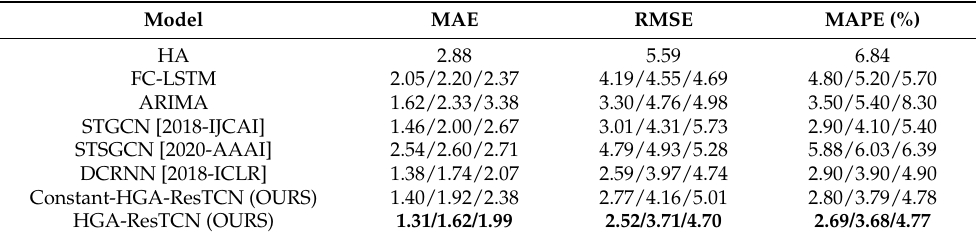
Table 1. The PEMS-BAY dataset comparison with other baselines in the next 15, 30 and 60 min.